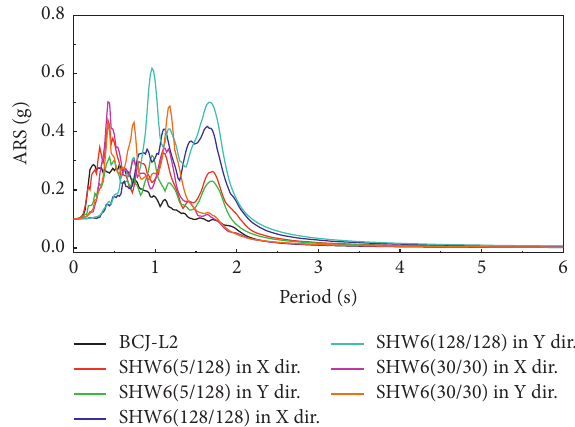
Figure 11: Acceleration response spectrum with the damping ratio of